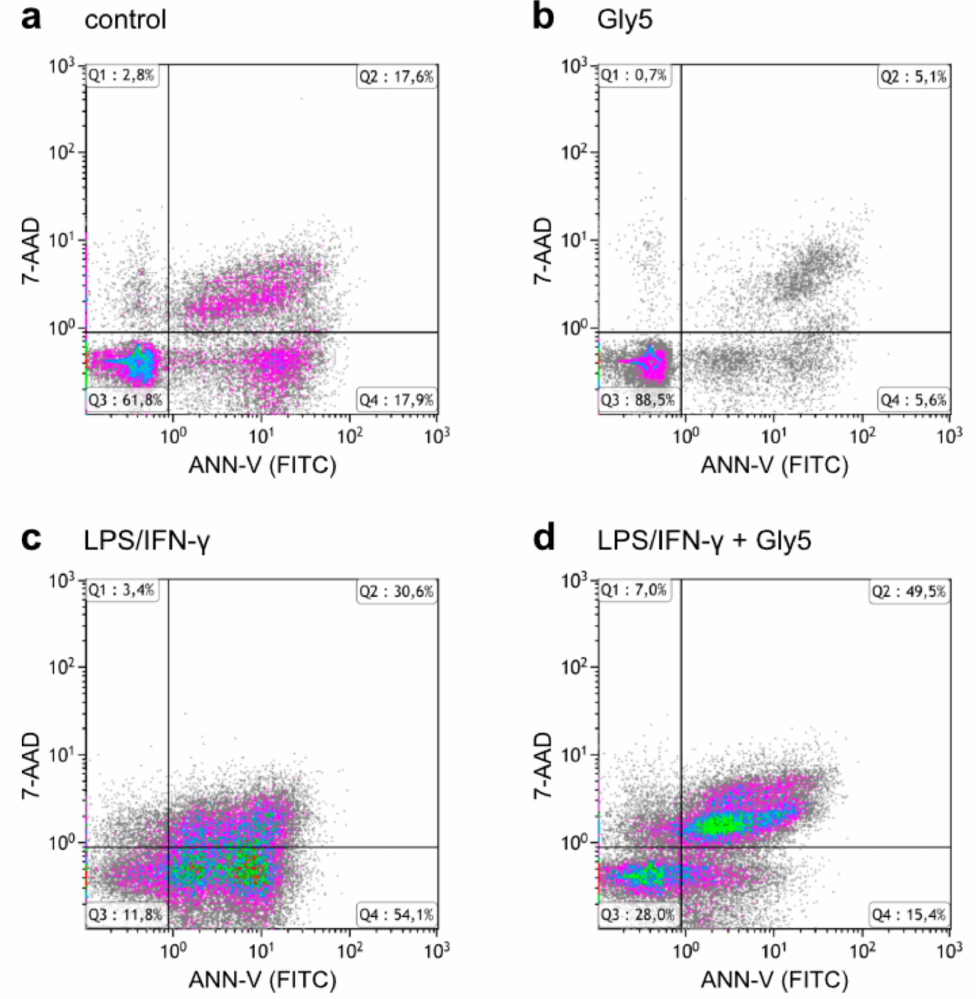
Figure 2. 7-AAD vs. FITC-ANN-V density plots of ( a ) untreated BV-2 cells, ( b ) cells treated with 5 mM glycine (Gly5), ( c ) cells treated with LPS / IFN- γ alone and ( d ) cells treated with both LPS / IFN- γ and 5 mM glycine (Gly5) after 24 h of incubation. Cell counts were gated to exclude cell debris. One experiment out of four independent experiments is